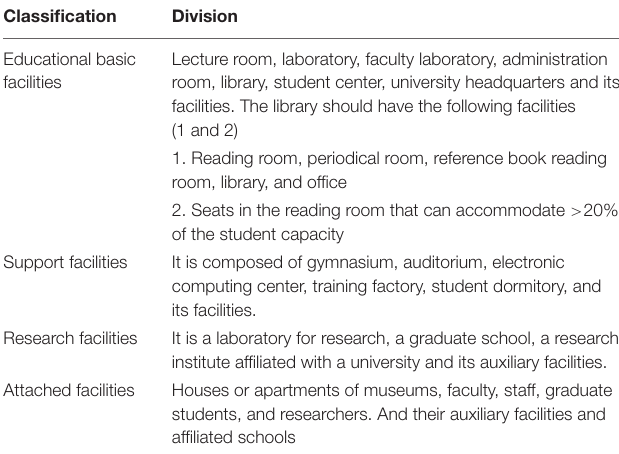
TABLE 1 | Classification of university